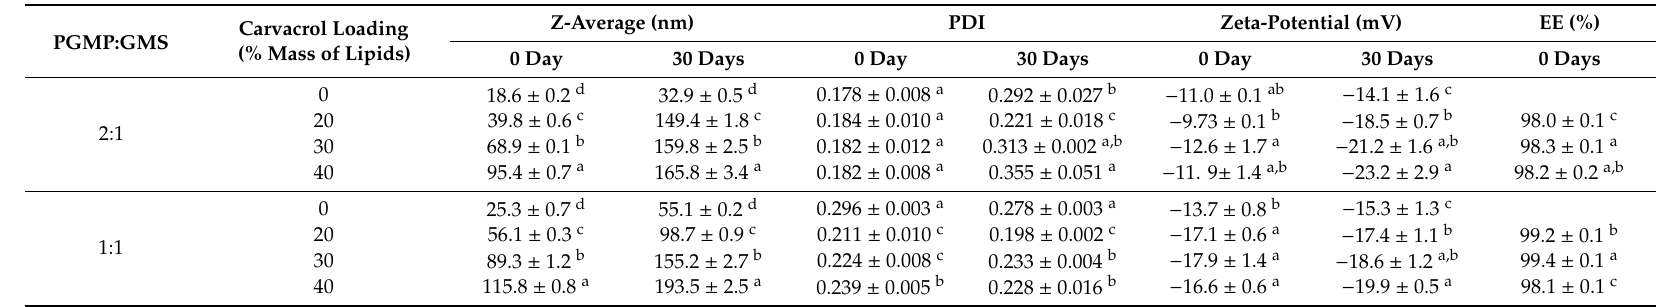
Table 2. The Z-average mean diameter (Z-average), polydispersity index (PDI), zeta-potential, and encapsulation e ffi ciency (EE%) values for the Car-SLNs dispersions 1